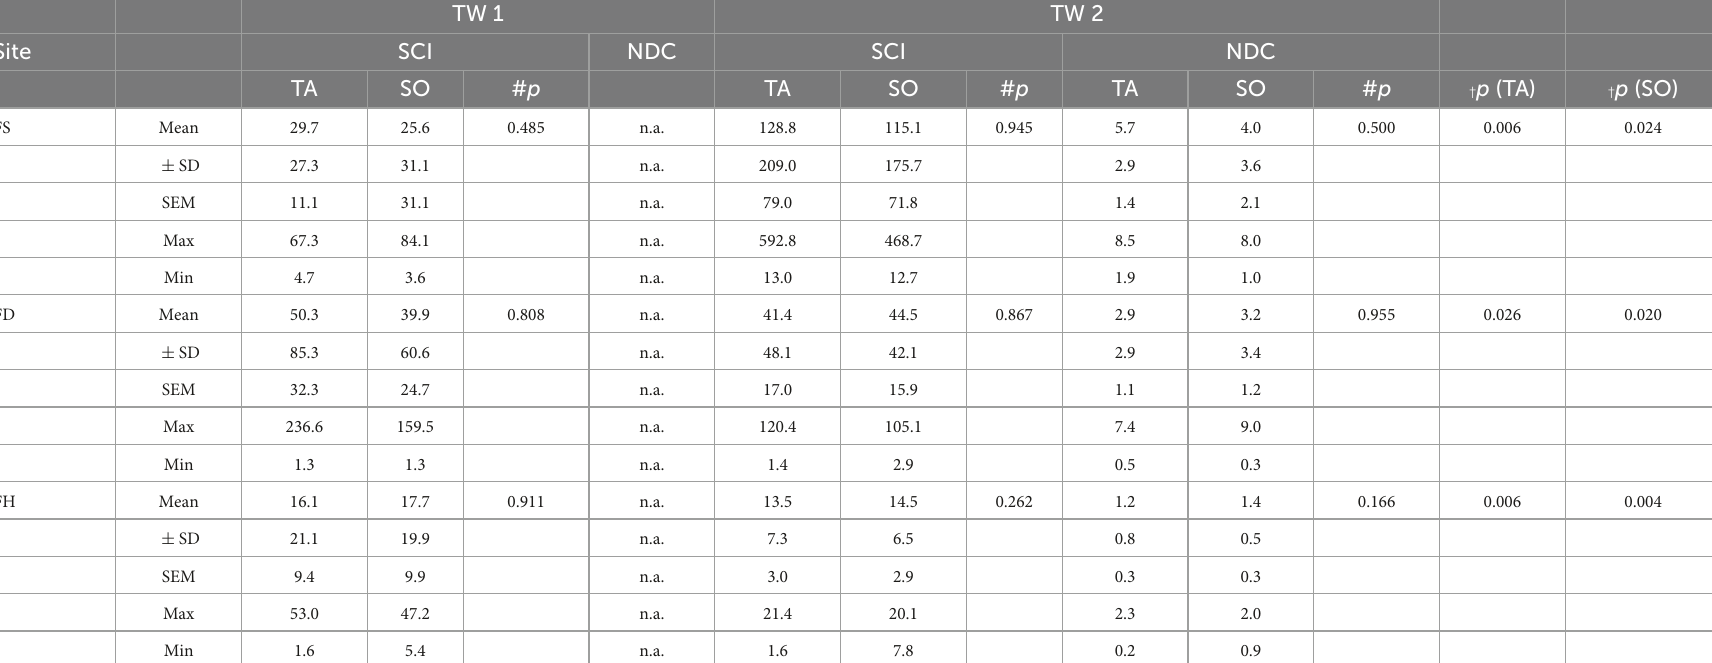
TABLE 4 Area under the